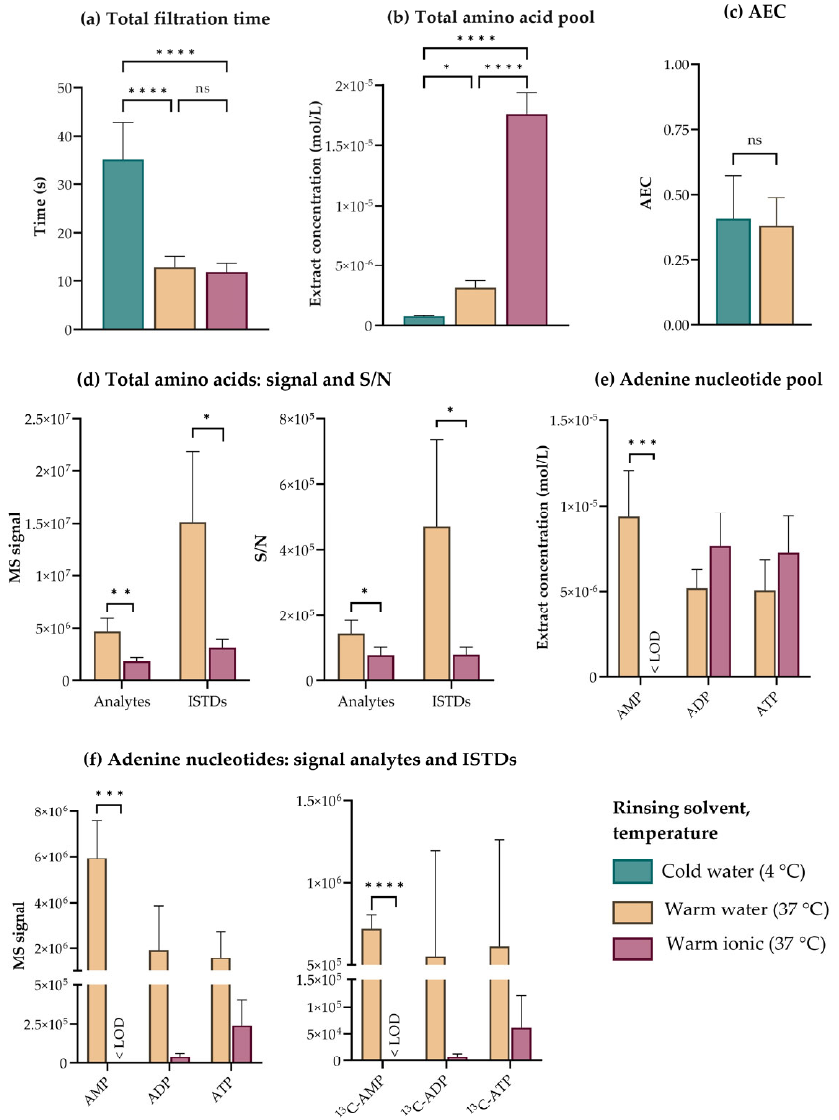
Figure 3. Effects of rinsing solvent and temperature. ( a ) Filtration times (s), ( b ) total amino acid extract concentrations (mol/L), and ( c ) adenylate energy charges (AECs) as measured for five OD 600 units of E. coli rinsed with 10 mL of cold water (4 ◦ ), warm water (37 ◦ C), or a warm rinsing solution ionic to the culture medium (37 ◦ C) under a controlled vacuum on polyvinylidene difluoride (PVDF) filters with a pore size of 0.45 µ m. ( d ) Total mass spectrometric (MS) signal (left panel) and signal- to-noise ratio (S/N) (right panel) of the total amino acid pool and corresponding 13 C, ( 15 N)-labeled internal standard (ISTDs), ( e ) adenine nucleotide extract concentrations (mol/L), and ( f ) MS signals (left panel) and S/N (right panel) of the adenine nucleotides and corresponding ISTDs, all in five OD 600 units of E. coli rinsed with 10 mL of water warm water (37 ◦ C) or a warm rinsing solution ionic to the culture medium (37 ◦ C) under a controlled vacuum on PVDF filters with a pore size of 0.45 µ m. The average ± SD of n = 4–8 technical replicates is presented. Significance levels for multiple comparisons from one-way ANOVA with Tukey’s multiple comparisons tests ( a , b ) and for pairwise comparisons are from two-tailed t -test assuming equal variances ( c – f ), are both marked ns: not significant; *: p ≤ 0.05; **: p ≤ 0.01; ***: p ≤ 0.001; ****: p ≤ 0.0001. LOD; limit of